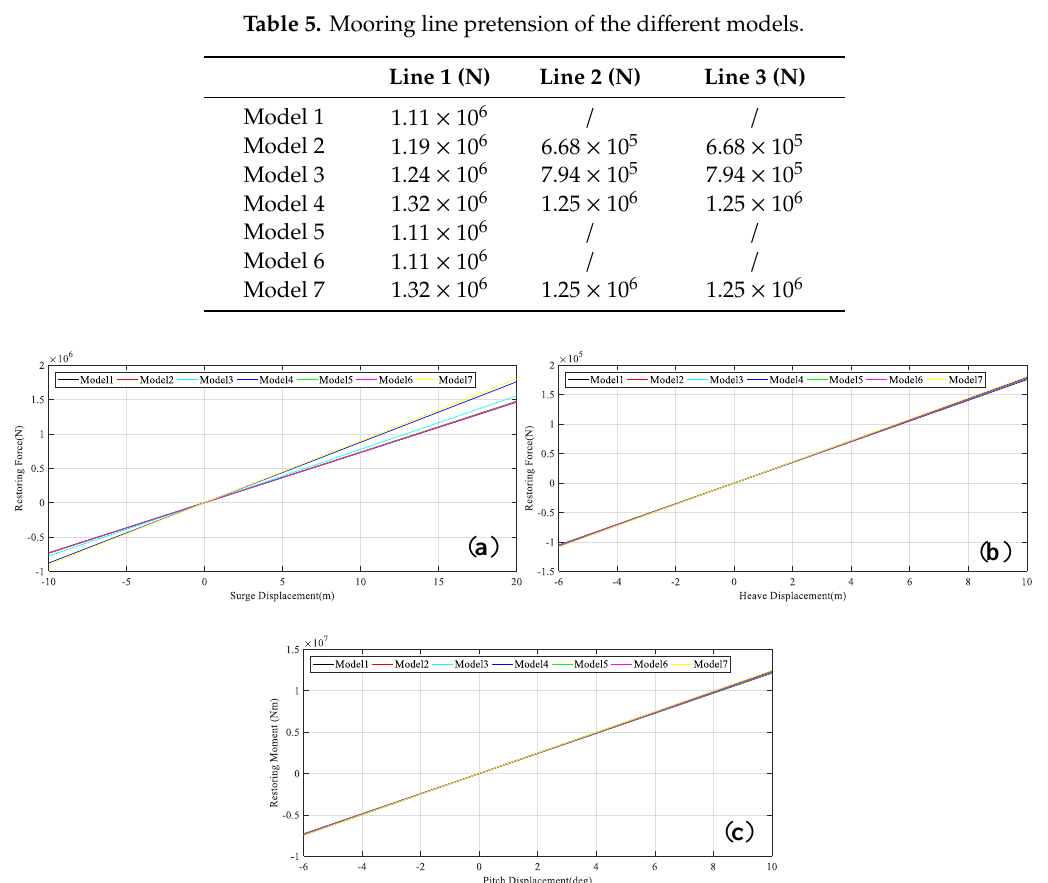
Table 6. Mooring stiffness of each model.